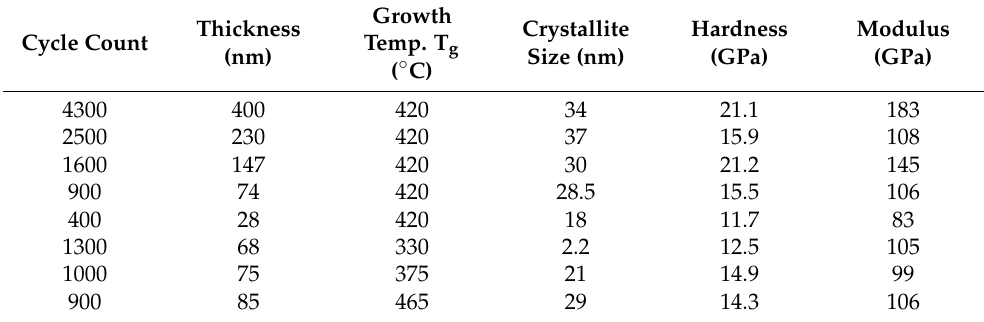
Table 2. XRD and averaged indentation hardness and modulus results given at 20 nm of tip displacement.